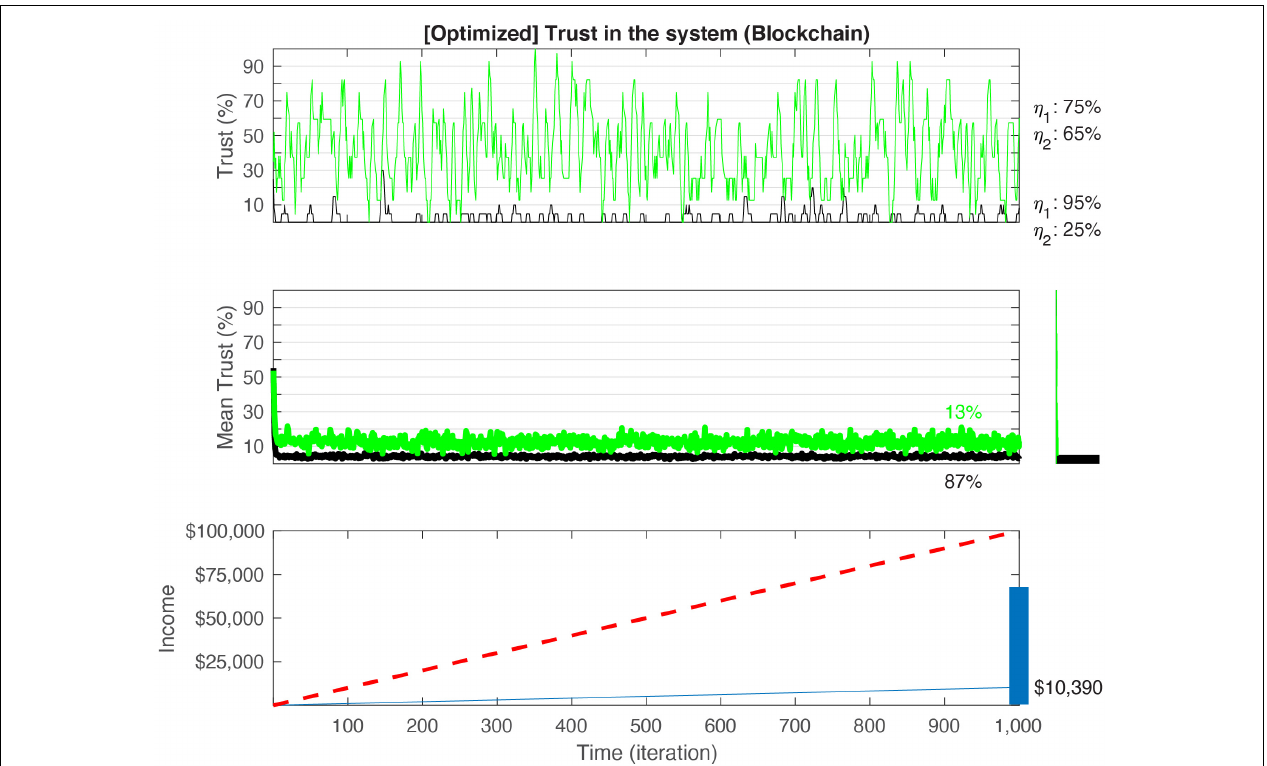
FIGURE 6 | Simulation of optimized Blockchain games with varying values of η 1 and η 2 . Top: depiction of two examples of games with η 1 >> η 2 and η 1 ≈ η 2 ratios. Middle: trust (see equation 2) decays in 87% of games to a value lower than the mean (5%), irrespective of the initial trust and the ratio between η 1 and η 2 (black line in the middle/top panels). Green line corresponds to the average of all trials that ended with trust values above the mean (Black: below the mean). A histogram of all final trust values is shown to the right. While high trust values have broader range, convergence to 0 trust is still dominant. Bottom: The total cumulative sum generated by the C-3PO is $10,390. Red dashed line depicts the optimal (“Full trust”) revenue that the C-3PO can generate if all 1,000 trials were played with maximum payoff (1,000 × $100). Blue rectangle on right axis corresponds to the upper/lower boundaries of income generated by the C-3PO, across all simulations. The values range between $462 and